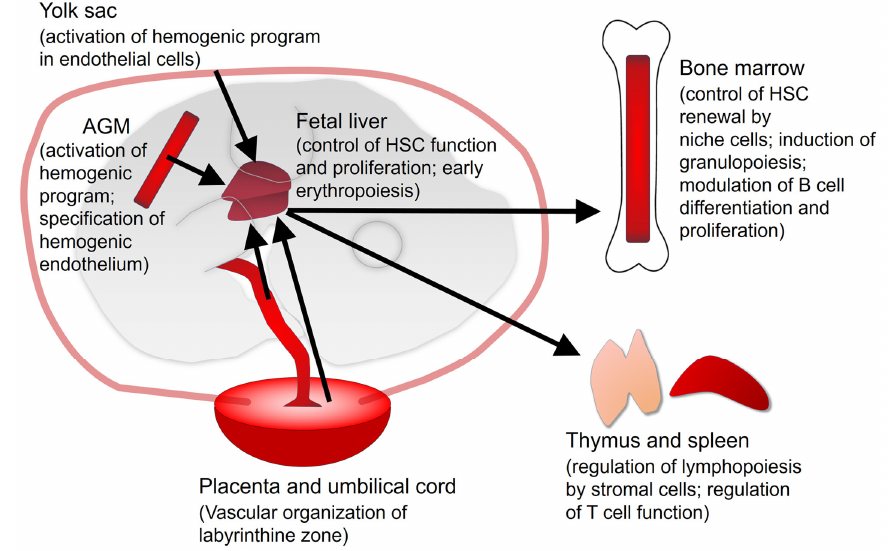
Figure 2 . Hematopoietic sites in the embryo ( left ) and adult mouse ( right ). The main functions played by vitamin A/RA signaling are described between parentheses. Black arrows represent the main routes of migration of progenitors between the hematopoietic organs and tissues. Exchange of progenitors between embryonic organs is also possible. It is unknown if RA signaling plays an intrinsic role on placental hematopoietic stem cells (HSC). AGM: Aorta ‐ Gonad ‐